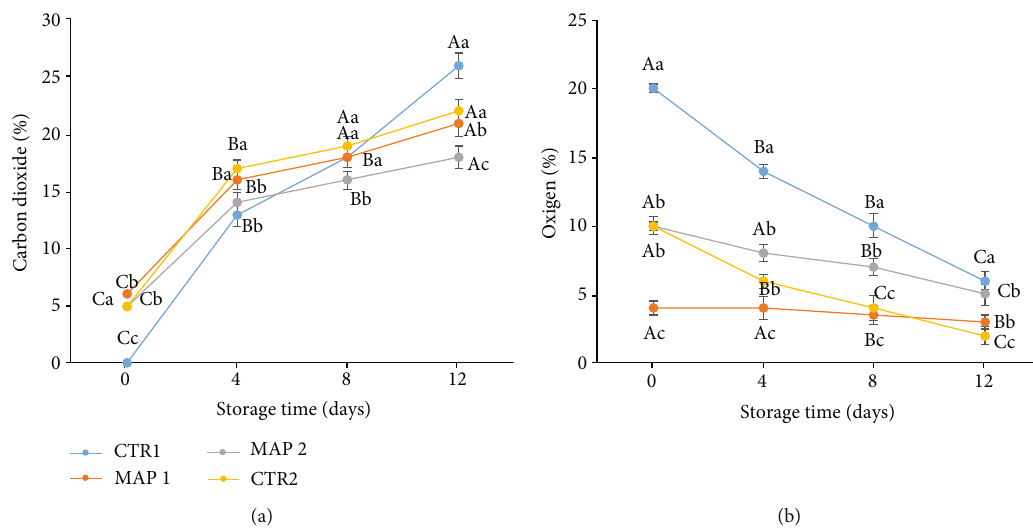
Figure 3: (a) Carbon dioxide content % (CO ) and (b) oxygen % (O ) inside packages with mulberry fruit stored at 4 ± 1 ° C and 90 ± 5 % RH 2 2 (relative humidity). Means ± SD with di ff erent letters are signi fi cantly di ff erent at p ≤ 0 : 05 using Tukey ’ s HSD test. Di ff erent capital letter denotes signi fi cant di ff erences ( p ≤ 0 : 05 ) among di ff erent treatments for the same sampling time. Di ff erent lowercase letter denotes signi fi cant di ff erences ( p ≤ 0 : 05 ) among di ff erent sampling times for the same treatment. Letter “ a ” or “ A ” denotes the highest